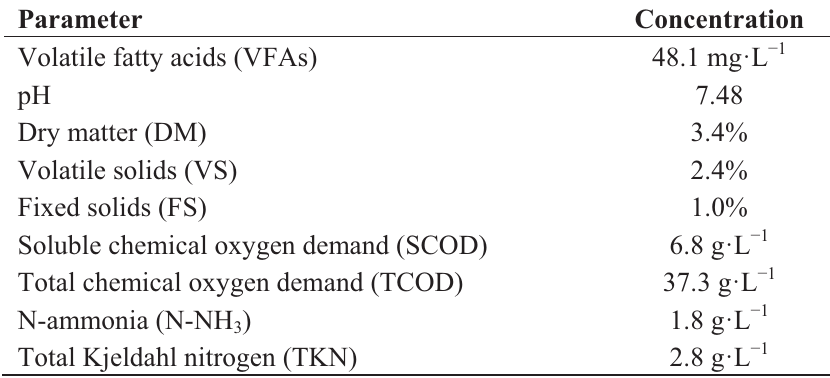
Table 2. The physico-chemical characteristics of the